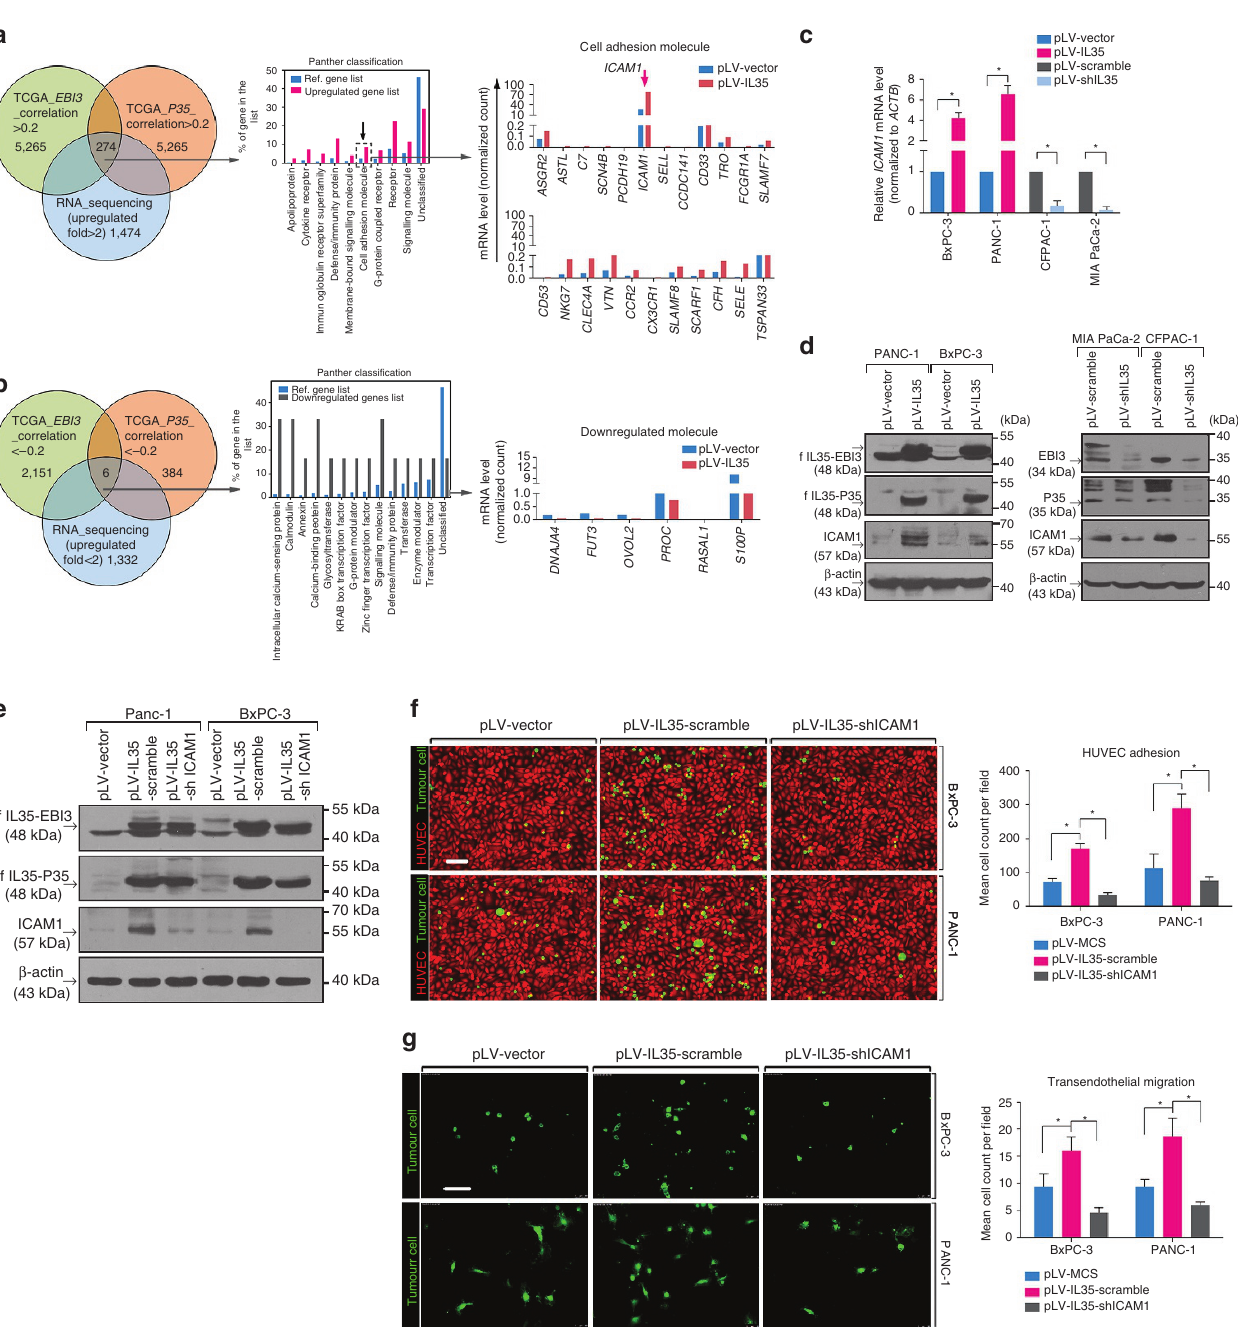
Figure 3 | ICAM1 is a novel IL-35 target gene critical for IL-35-induced endothelial adhesion and TEM. ( a ) Bioinformatics analysis of upregulated genes in genome-wide mRNA sequencing of IL-35-overexpressing PANC-1 cells versus control PANC-1 cells (left). The genes significantly correlated with EBI3 and P35 in the TCGA mRNA expression analysis were subjected to PANTHER classification (middle). The candidate cell adhesion genes are shown (right). ( b ) Bioinformatics analysis of downregulated genes as in a . ( c , d ) Cells were transfected with lentiviruses to upregulate or downregulate IL-35 expression. Forty-eight hours later, RT–PCR ( c ) and western blotting ( d ) were performed to verify the regulating effect of IL-35 on ICAM1 in the indicated cell lines. ( e ) Western blotting assays to confirm stable ICAM1 knockdown in the indicated cell lines. ( f ) Endothelial adhesion assays of indicated cells performed as described in Fig. 2a. ( g ) TEM assays performed as described in Fig. 2d. Experiments were replicated three times; shown are the mean values ± s.d. Unpaired t -test was used in c , f and g . Tests of significance are two-sided. * P o 0.05. Scale bars, 100 m